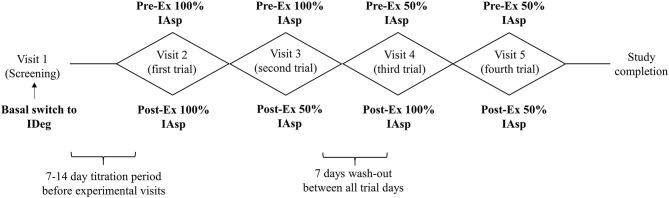
Schematic overview of the trial design with reference to the four interventional cross over arms involving peri-exercise adjustments to bolus insulin aspart on a stable background of insulin degludec. IAsp, insulin aspart; IDeg, insulin degludec.